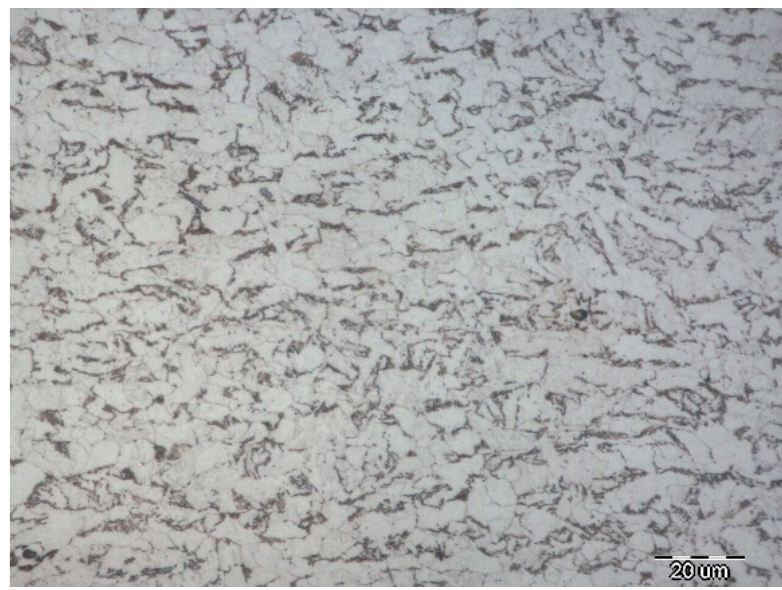
Figure 6. Microstructures of the base metal (with a magnification of 1000).